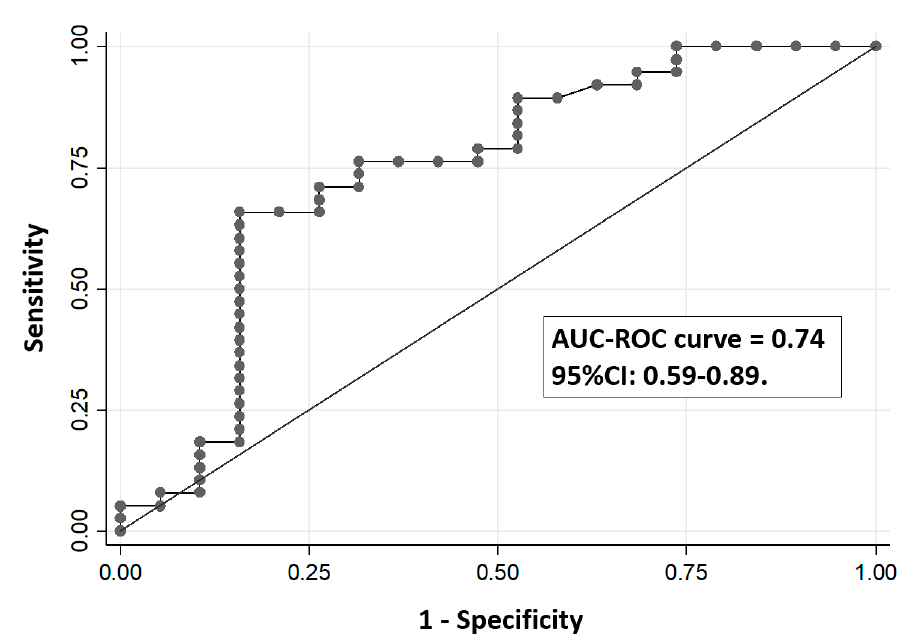
Figure 4. Receiver operating characteristic (ROC) curve to assess the capacity of the percentage of DNA methylation at the -783 CpG position of the PPARGC1A gene in leukocytes to classify insulin-sensitive versus insulin-resistant subjects. AUC: Area under the curve.